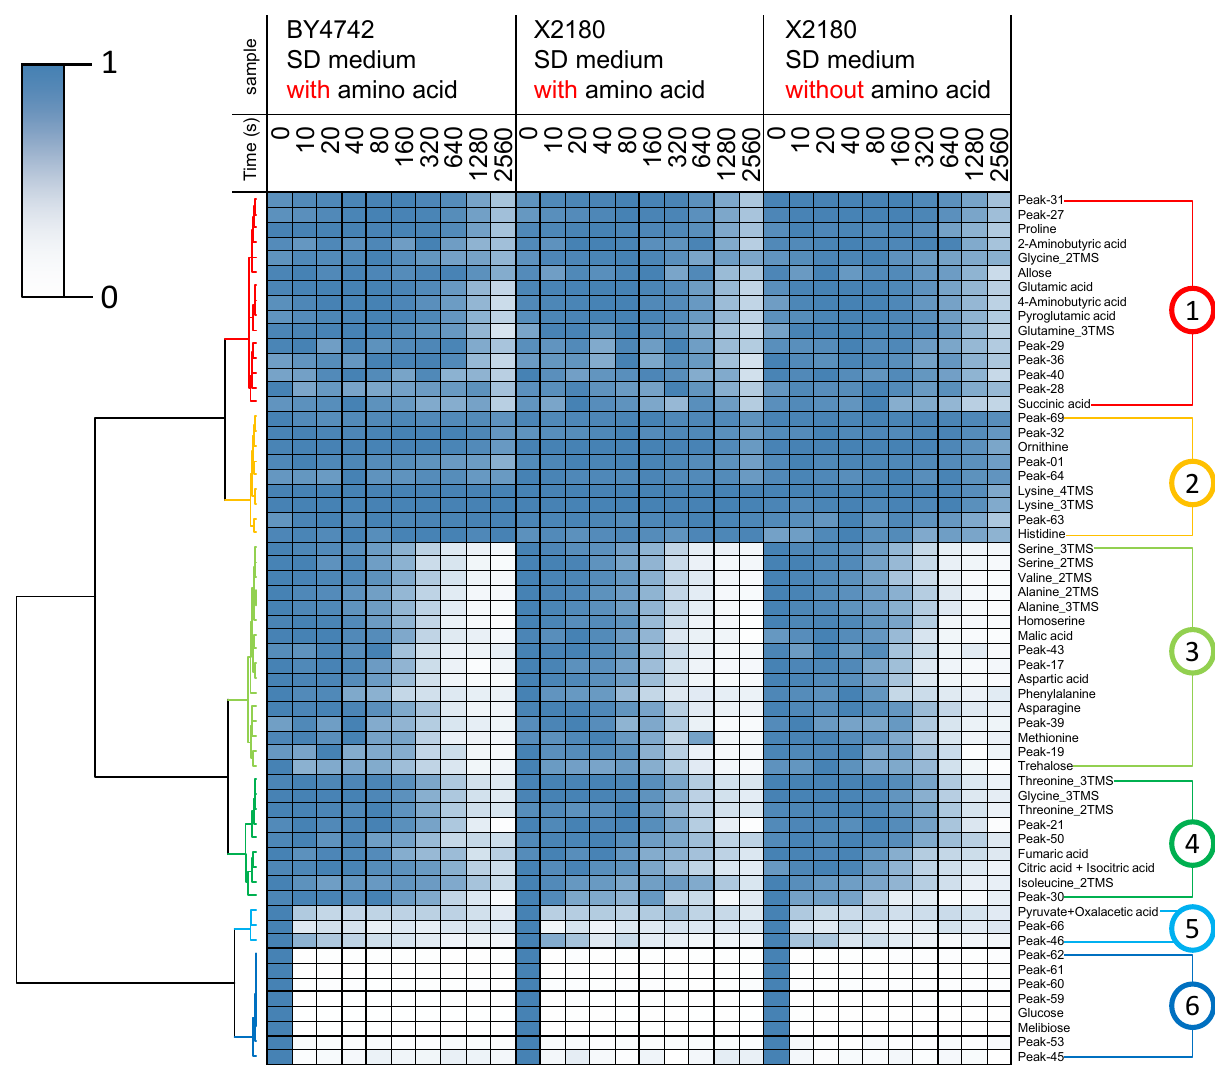
Figure 2. Metabolic turnover of detected peaks. The heat map indicates the ratio of the 12 C-monoisotopic mass at each sampling time. The color gradation is indicated at the upper left. The data are standardized by the maximum value of each isotopomer. Peak clusters were calculated by hierarchical cluster analysis (HCA) using Euclidian distances and Ward’s method linkage